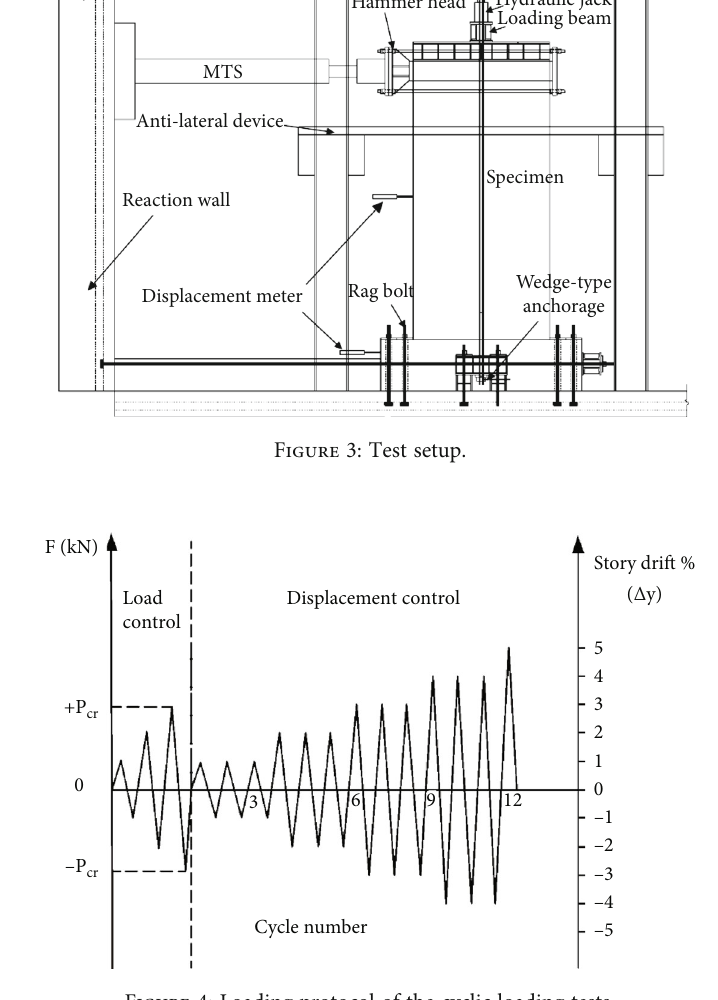
Figure 4: Loading protocol of the cyclic loading